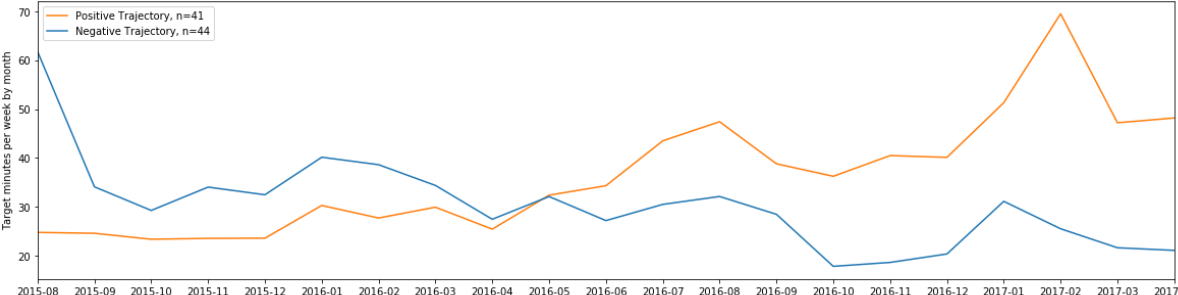
Figure 6. Average trend for each group from August 2015 to April 2017, which includes May, June, and July of